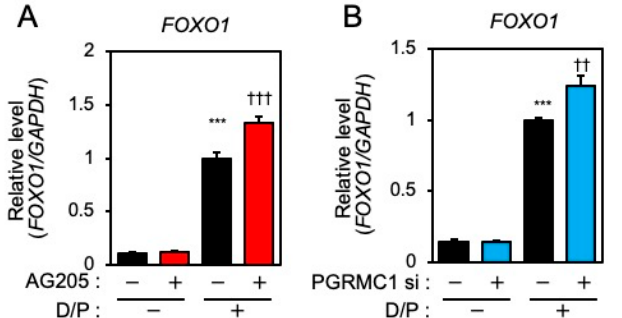
Figure 3. PGRMC1 inhibition and knockdown promote D/P-induced FOXO1 expression. ESCs were pre-treated with the PGRMC1 inhibitor AG-205 ( A ) for 1 h or PGRMC1 siRNA ( B ) for 1 day and then stimulated with D/P for 2 days. Expression of FOXO1 was determined by real-time RT-PCR. GAPDH was used as the reference gene. Red and blue bars show the AG205-treated and PGRMC1 siRNA-transfected group, respectively. *** p < 0.001 vs. control. †† p < 0.01, ††† p < 0.001 vs.